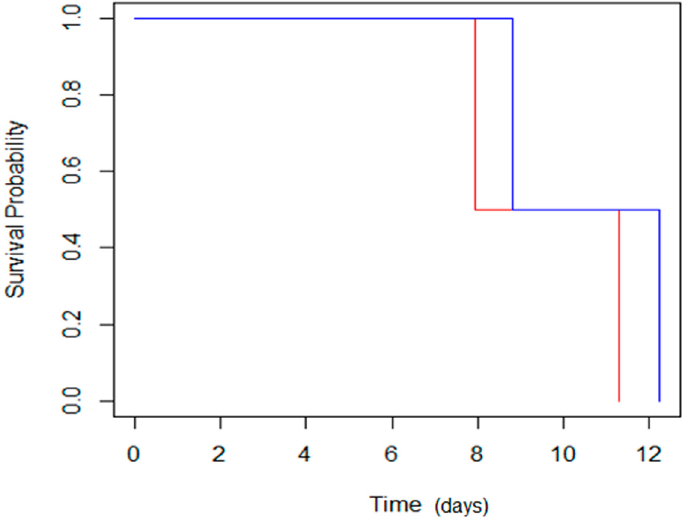
Figure 11. Regression of Box–Cox by the Breslow method; the blue line indicates survival of the seeds treated with magneto-priming, and the red line represents the untreated seeds. The values were obtained by the Box–Cox regression model, with the likelihood ratio test = 0.62 and p = 0.4, and a 0.95 confidence interval.